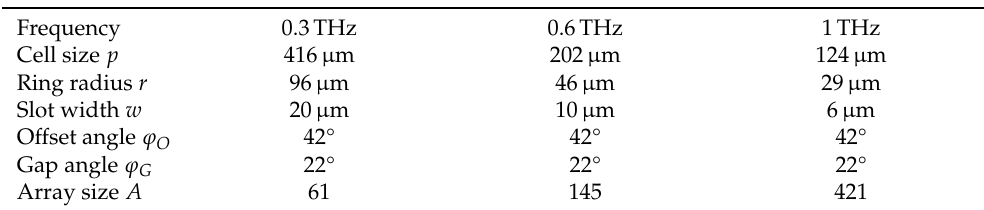
Table 1. Geometric parameters of the aDSRR biosensors with resonance frequencies of 0.3THz, 0.6THz and